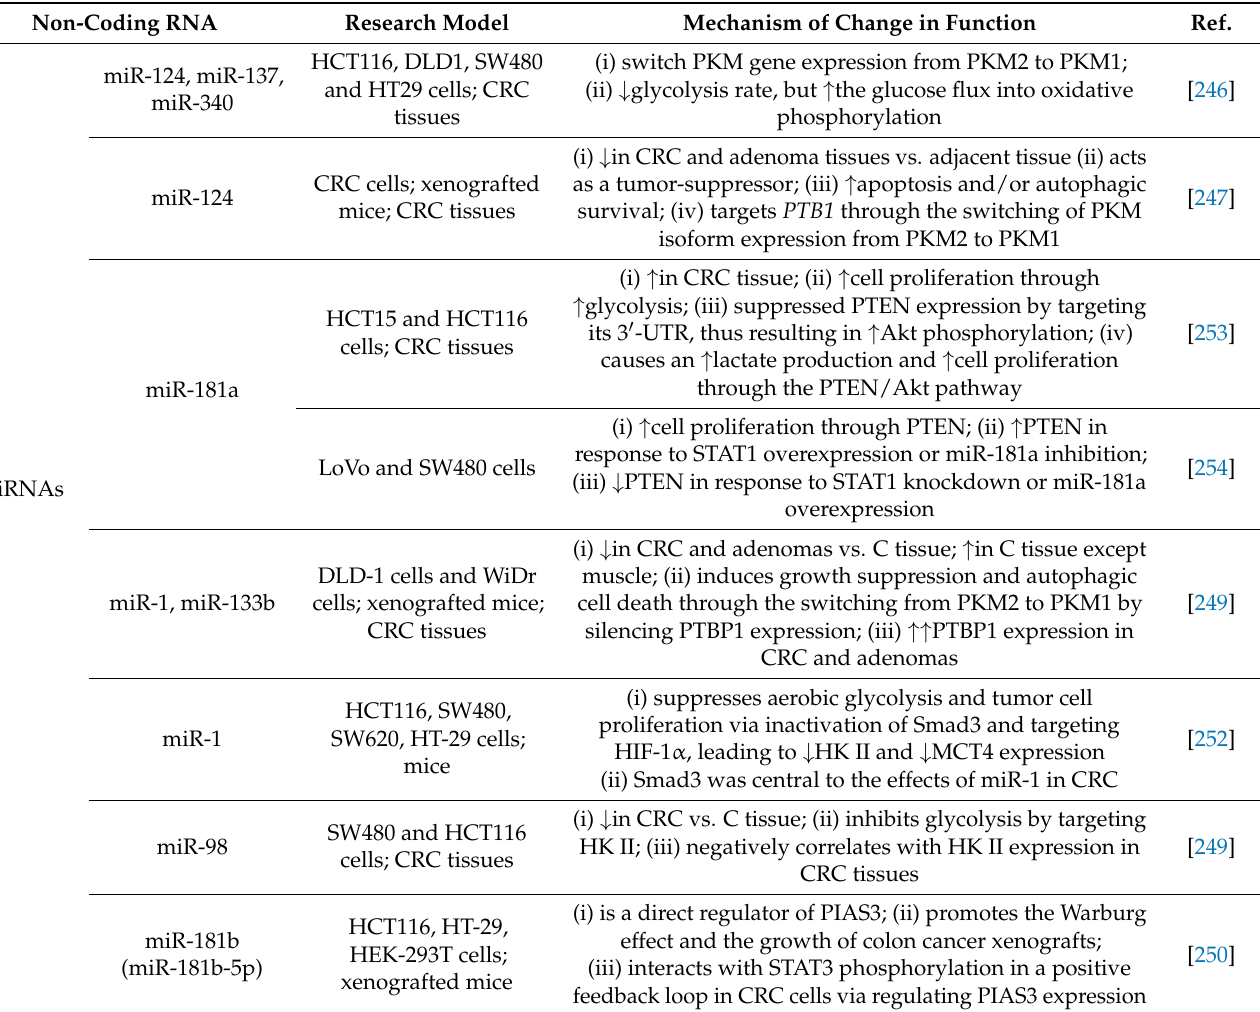
Table 3. Examples of non-coding RNAs that play role in glucose metabolism as potential targets for treatment in colorectal cancer. Non-Coding RNA